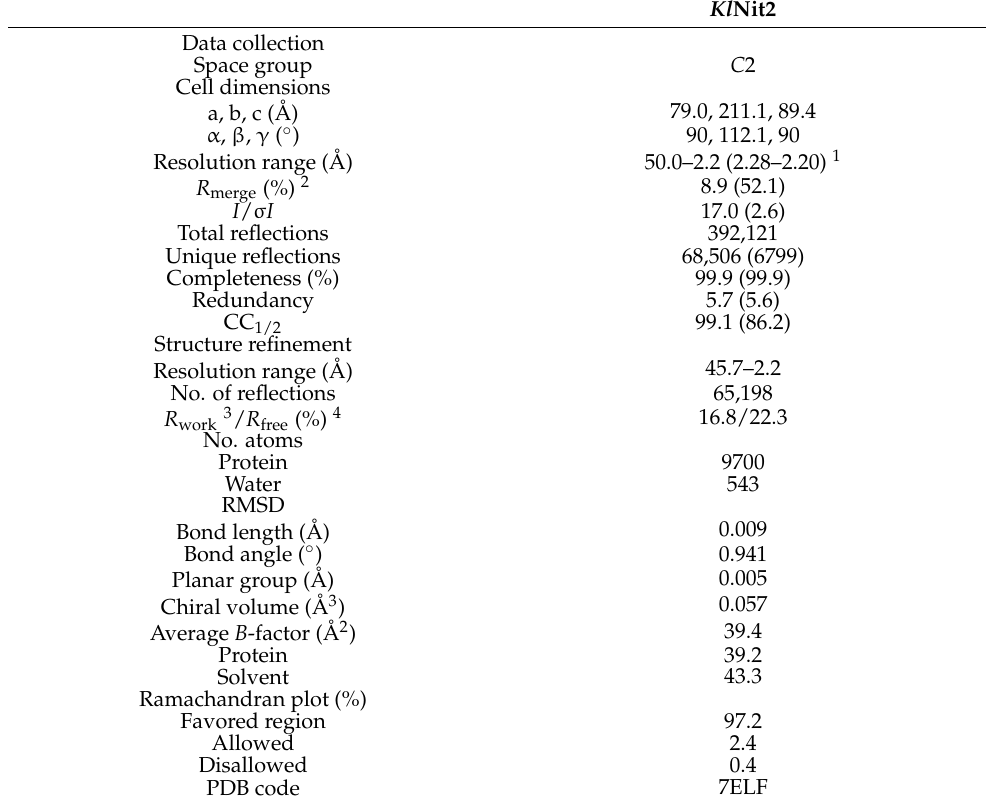
Table 1. Data collection and refinement statics for Kl